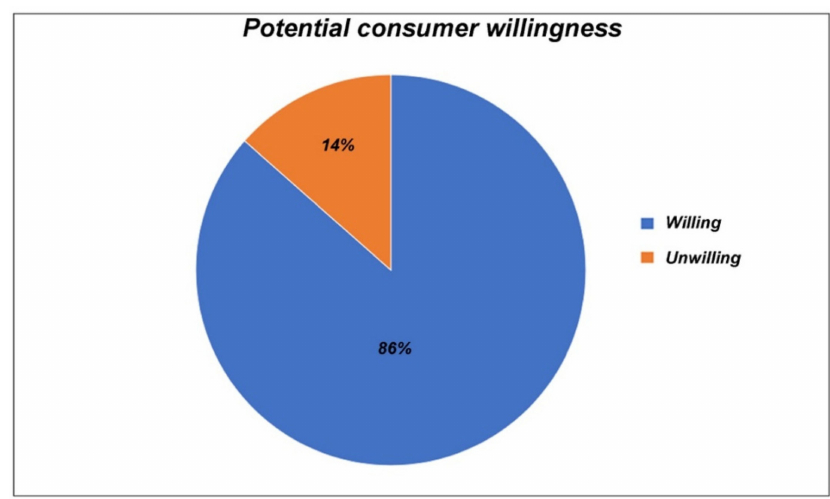
Figure 16. Residents of the potential consumer